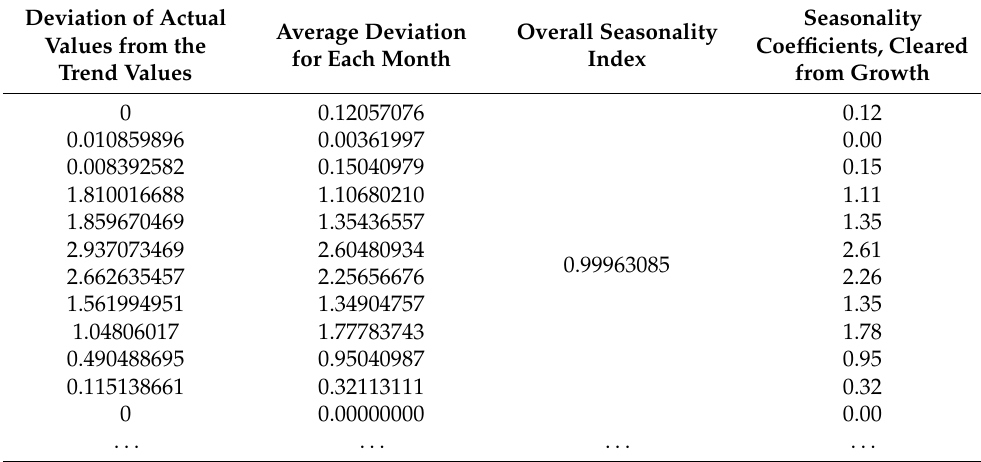
Table 4. The results of determining the coefficients of